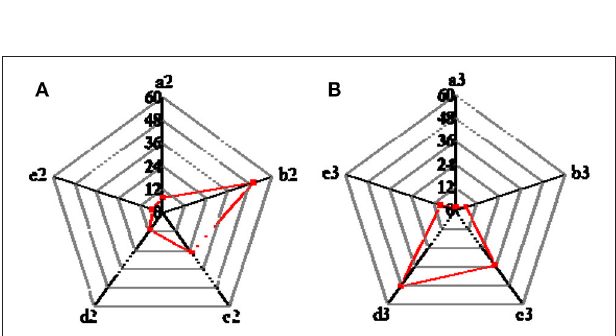
FIGURE 4 | College students’ cognition and attitudes on entrepreneurial values [ (A) . College students’ recognition of entrepreneurship. a2 Science and technology projects; b2. Entrepreneurial activities based on Innovation; c2. Open work; d2. Enterprise and company; e2. Else (B) . College students’ mastery of entrepreneurship-related policies and measurements. a3. Very well; b3. Understand; c3. General; d3. Do not understand; e3. Don’t